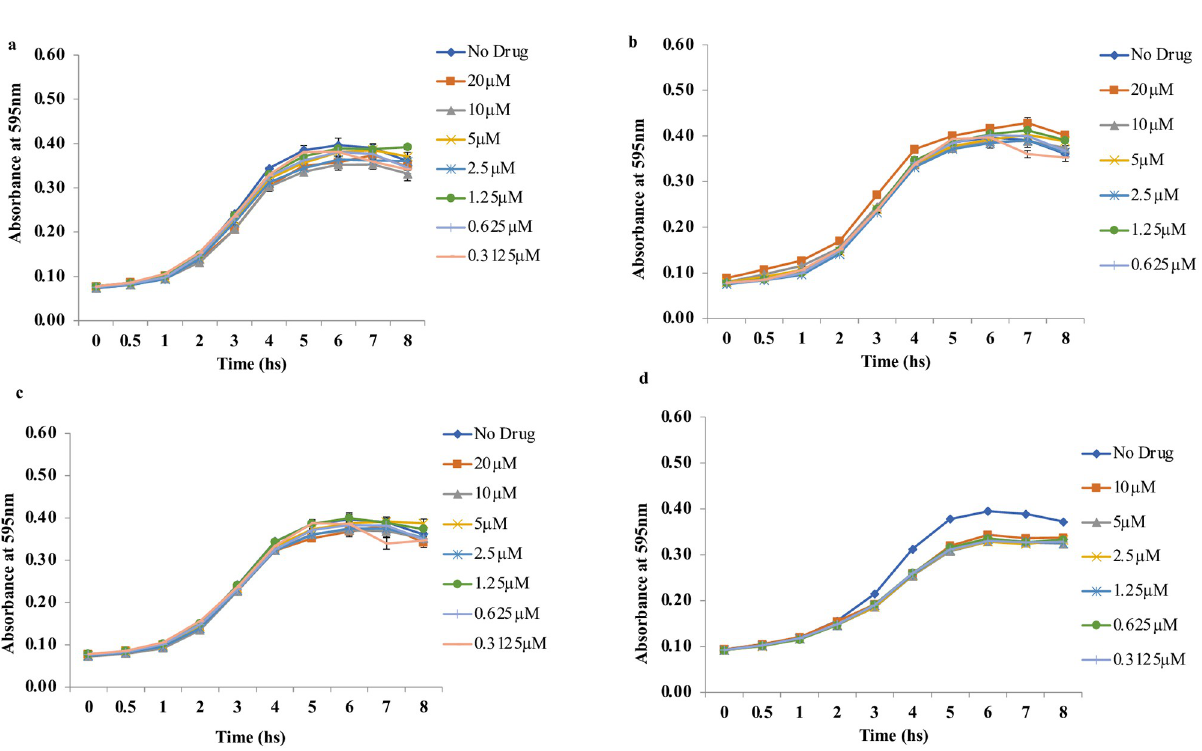
Fig 3. Hits did not significantly alter growth kinetics of EAEC strains at the various concentrations tested over 8 h: Growth kinetics of EAEC 042 with different concentrations of a) MMV688978, b) MMV687800, c) MMV688990, d) Growth kinetics of MND005E with different concentrations of MMV688990. Error bars represent the standard deviation among